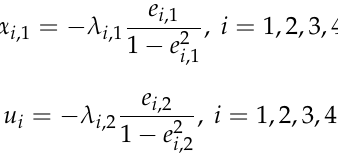
Figure 2. Tracking errors x i ,1 − y d for 1 ≤ i ≤